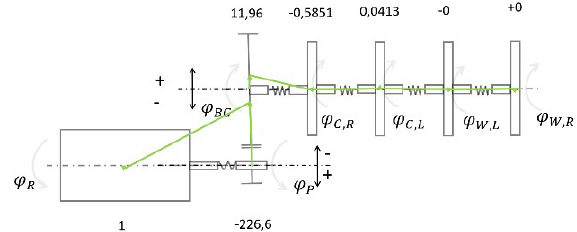
Figure 16. Seventh natural mode of torsion oscilla- tions [3].